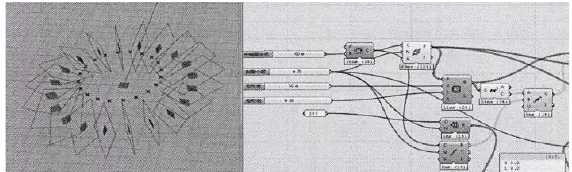
Figure 6: Modeling the third stage